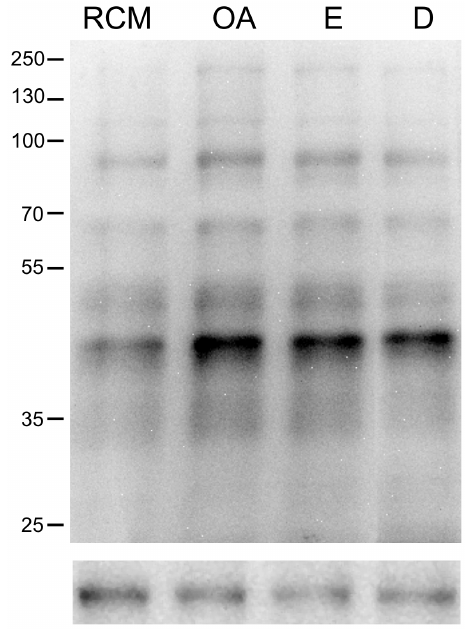
Figure 7. Effect of phosphatase inhibitors on phosphorylation of threonine residues of human sperm proteins. Sperm were selected in NCM and then re-suspended in RCM in the absence (RCM) or in the presence of 10 nM okadaic acid (OA), 90 nM endothall (E), or 0.1 nM deltamethrin (D), for 1 min. Then, the samples were processed for western blot analysis with a monoclonal anti-p-Thr antibody. Molecular mass of selected bands is indicated at the right. The lower panels indicate load control with anti b -tubulin antibody. The immunoblots shown are representative of three different experiments with three different